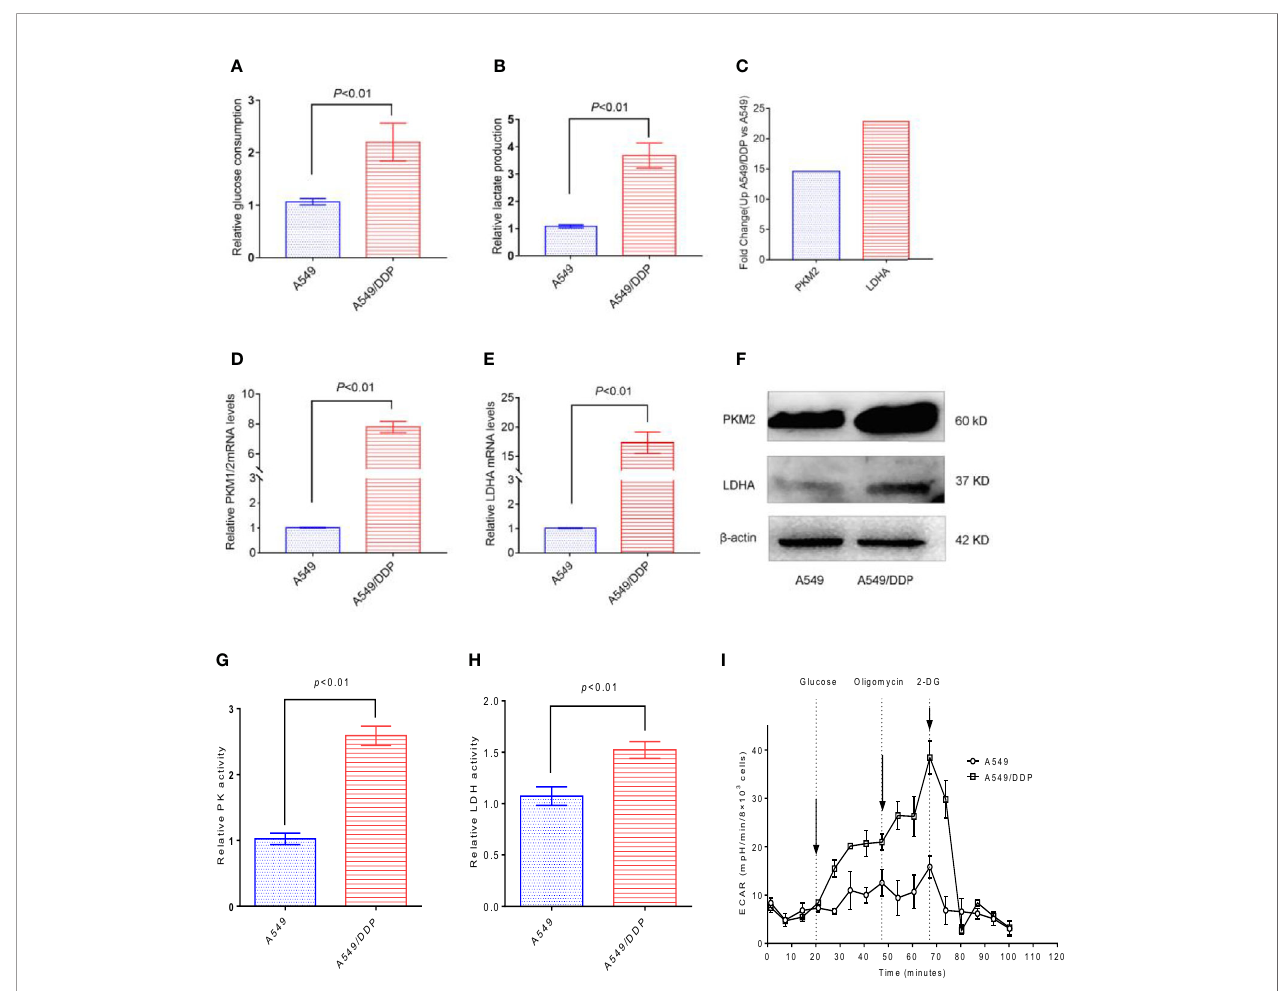
FIGURE 3 | The glycolysis level of A549/DDP cells increased. (A) Glucose consumption and (B) lactate production were measured in A549 cells and A549/DDP cells. (C) KEGG results showed the expression of PKM2 and LDHA in A549 cells and A549/DDP cells. (D, E) qRT-PCR assay for the expression of glucose metabolizing enzymes PKM2 and LDHA in A549 cells and A549/DDP cells. The expression of glucose metabolizing enzymes PKM2 and LDHA increased in A549 cells and A549/DDP cells, as shown by Western blot analysis (F) . Determination of the activity of glucose-metabolizing enzymes PK and LDH in A549 cells and A549/DDP cells (G, H) . Determination of glycolytic stress in A549 cells and A549/DDP cells (I) . The results are presented as mean ± S.D; the experimental results are presented in triplicate. PKM2, pyruvate kinase M2; LDHA, lactate dehydrogenase